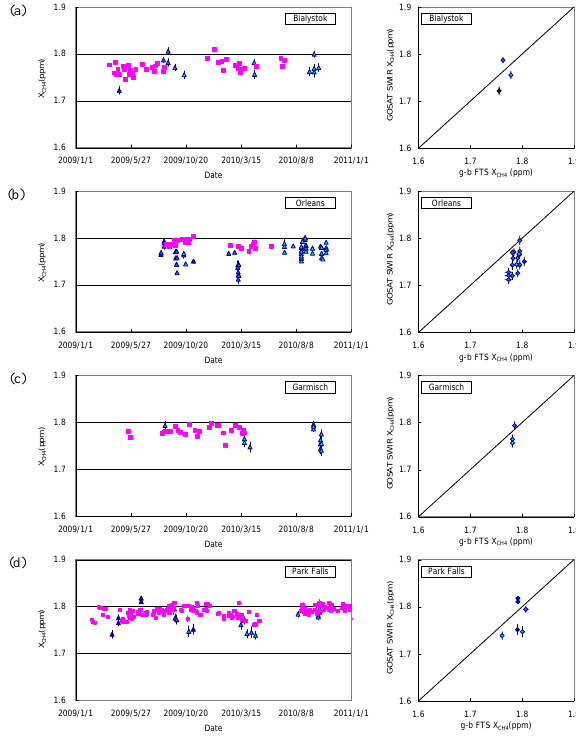
Fig.A4. 5 Fig. A3. Time series of GOSAT TANSO-FTS SWIR (blue trian- gles) and g-b FTS (pink squares) X CH and their scatter diagrams 4 for (a) Bialystok, (b) Orl´eans, (c) Garmisch, (d) Park Falls, (e) La- mont, (f) Tsukuba, (g) Darwin, (h) Wollongong, and (i) Lauder. The GOSAT data were retrieved within ± 2 degrees latitude/longitude box centered at each g-b FTS site and the g-b FTS data were the mean values measured within ± 1 h of GOSAT overpass